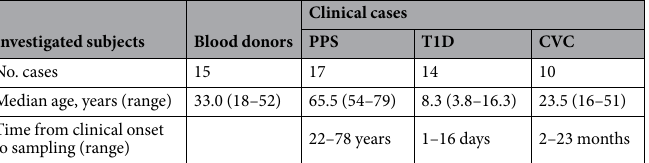
standard cycling profile reduced to 42 cycles. Results were confirmed by analysis of the dissociation profile (flu- orescence readings collected at temperature increments from 55 °C to 95 °C) and are summarized in Table S4A. The median Ct value was 37.8 (range 37.0–38.2) for PPS cases, 35.7 for T1D cases (range 35.1–37.4). As shown in Table S4B, comparison with Ct values obtained using known copy numbers of pUC57-5UTR plasmids allowed to in cell cultures exposed to samples of PPS and T1D patients is comparable to what documented in cardiac tissue of idiopathic cardiomyopathy [about 500 EV genome copies/ μ g of total extracted nucleic acids 15 ]. The low virus levels indicate that replication-defective agents play a role in chronic EV infection. In order to evaluate tests sensitivity under conditions identical to those adopted for clinical samples, biologi- cally titrated EV strains representative of the A, B, C, D species (CV-A16, CV-B4, PV-2, EV-D94) were subjected to serial tenfold dilutions in complete medium. RNA was extracted from each dilution and utilized for reverse transcription. Primer pairs attained extreme sensitivity. Table 2 shows that molecular assays tended to remain positive with samples diluted up to 10 − 9 . Thus, at least for the investigated EV types, the sensitivity of PCR assays targeting the 5 ′ UTR, 2 C, and 3Dpol regions exceeded by 10 to 100-fold that of biologic virus titration.